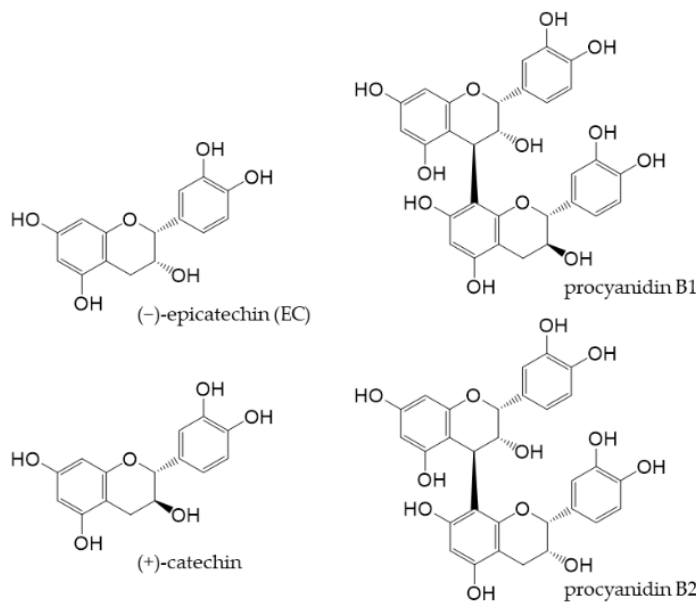
Figure 4. Chemical structures of main flavan-3-ols in cocoa powder. EC and procyanidin B1 in cocoa powder are metabolized in the intestines (Figure 5) [45]. Phenolic compounds in cocoa are metabolized in both the small and large intestine to produce metabolites that affect human health. [41,45,46].